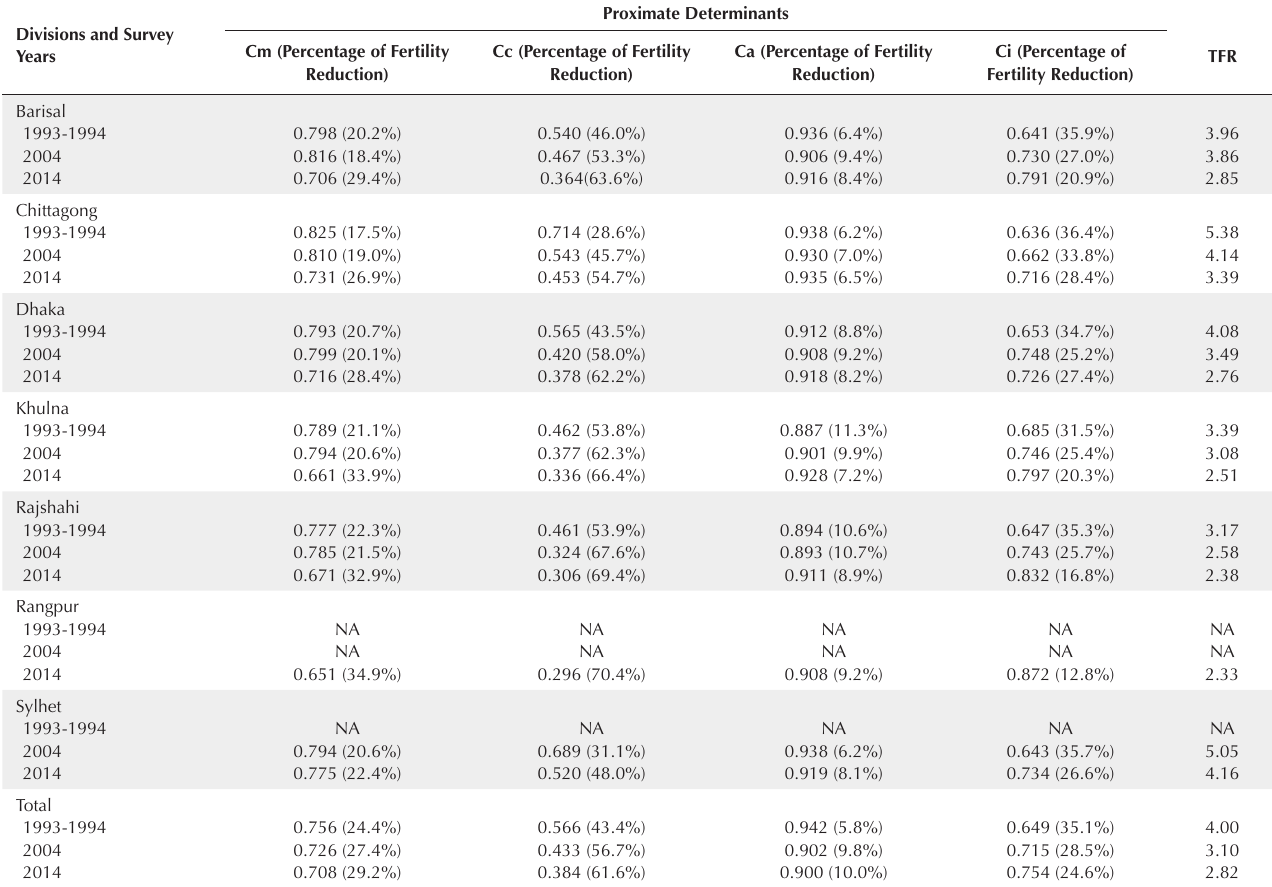
Proximate Determinants